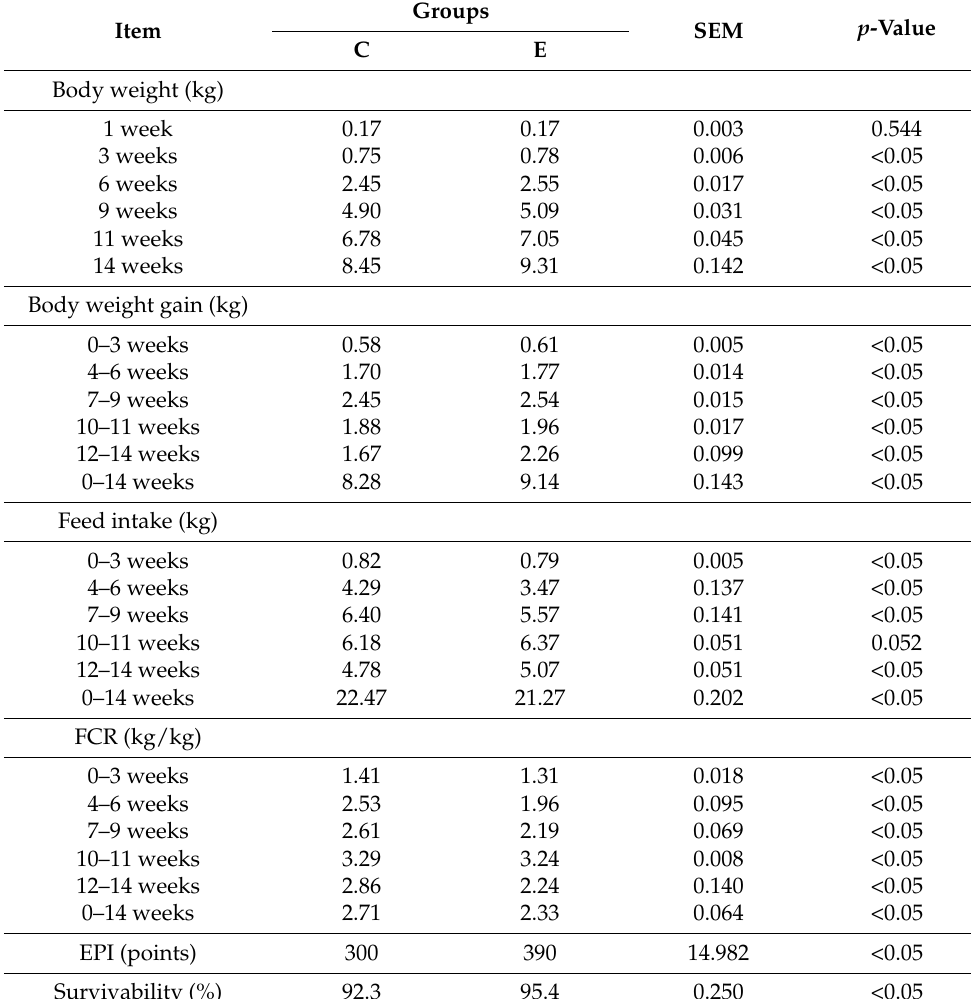
Table 2. Rearing results of turkey hens.